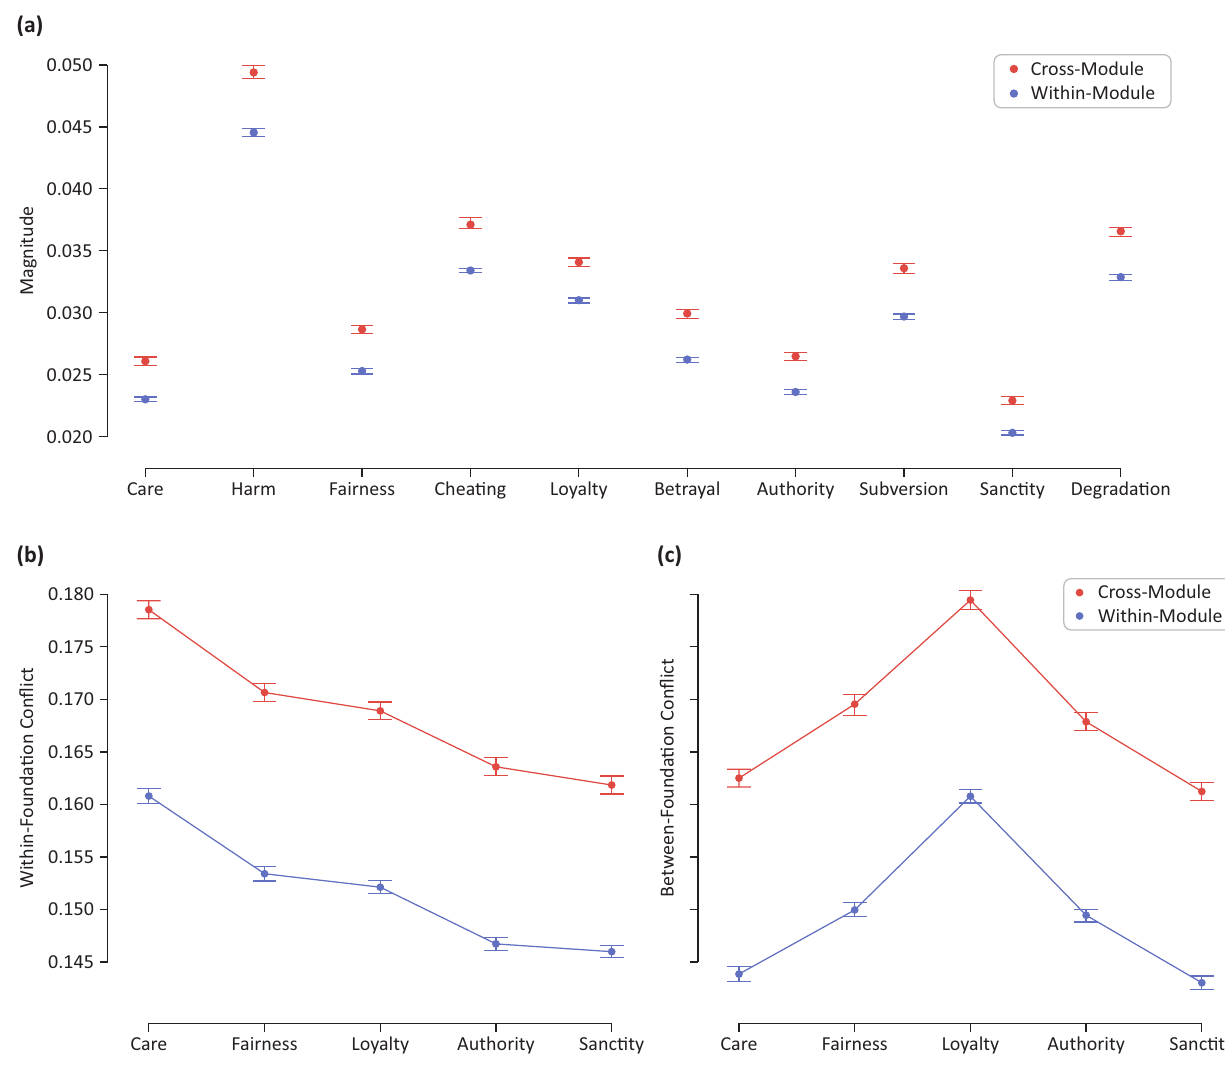
Figure 8. Moral content across within-module and cross-module scenes: (a) Representation of moral foundations; (b) Representation of within-foundation conflict; (c) Representation of between-foundation conflict. Notes: N = 894 screen- plays. Error bars represent 99% confidence intervals estimated with 1,000 bootstrap iterations. Outliers above 95% were removed. Source: